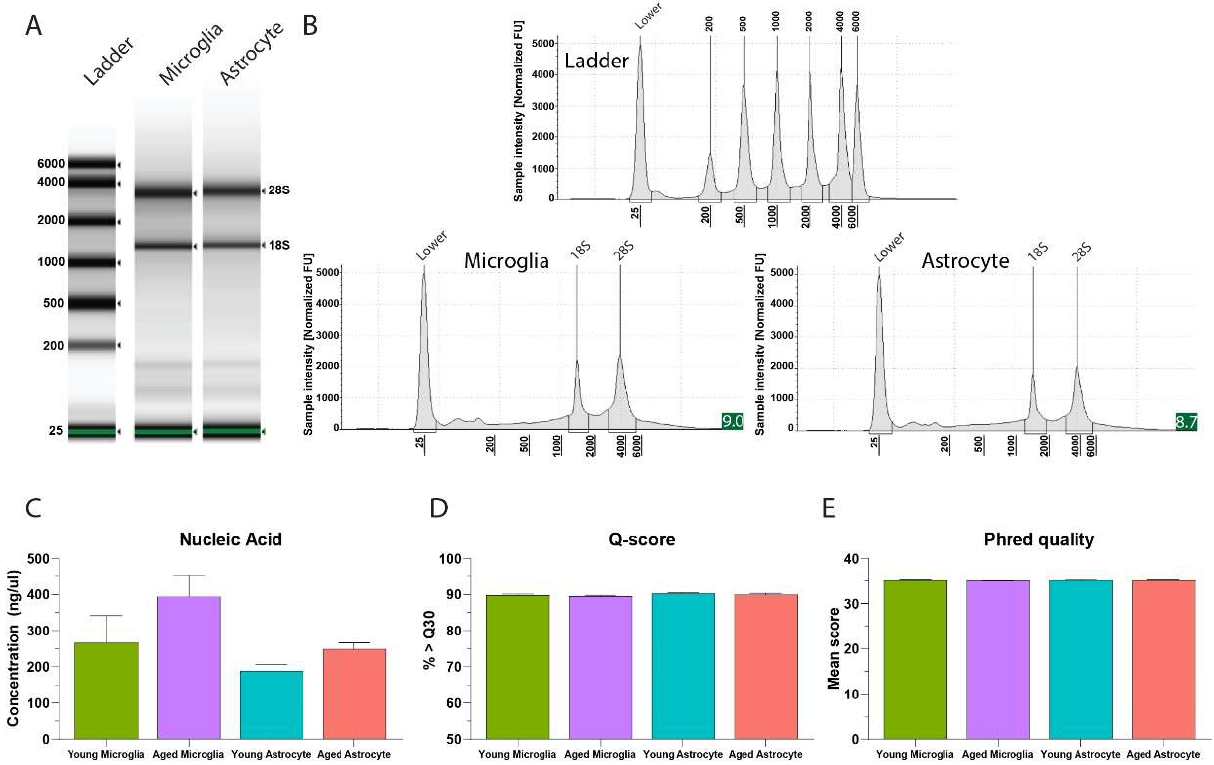
Figure 8. RNA quality, integrity, and yield for transcriptomic applications after sequential cell specific isolation. ( A ) Representative electrophoresis demonstrating RNA quality of sequentially extracted microglia and astrocyte samples from combined cortical and hippocampal tissue from the adult mouse brain. ( B ) Electropherogram showing 18S and 28S peaks of microglia and astrocyte samples, with integrity scores of 9.0 and 8.7 respectively evidencing high quality RNA with minimal degradation. ( C ) RNA yields following sequential isolation of microglia and astrocytes from young and aged brains. Quality control of transcriptomic sequencing of isolated microglial and astrocytes demonstrated by ( D ) Q-score > 30 and ( E ) mean Phred scores.